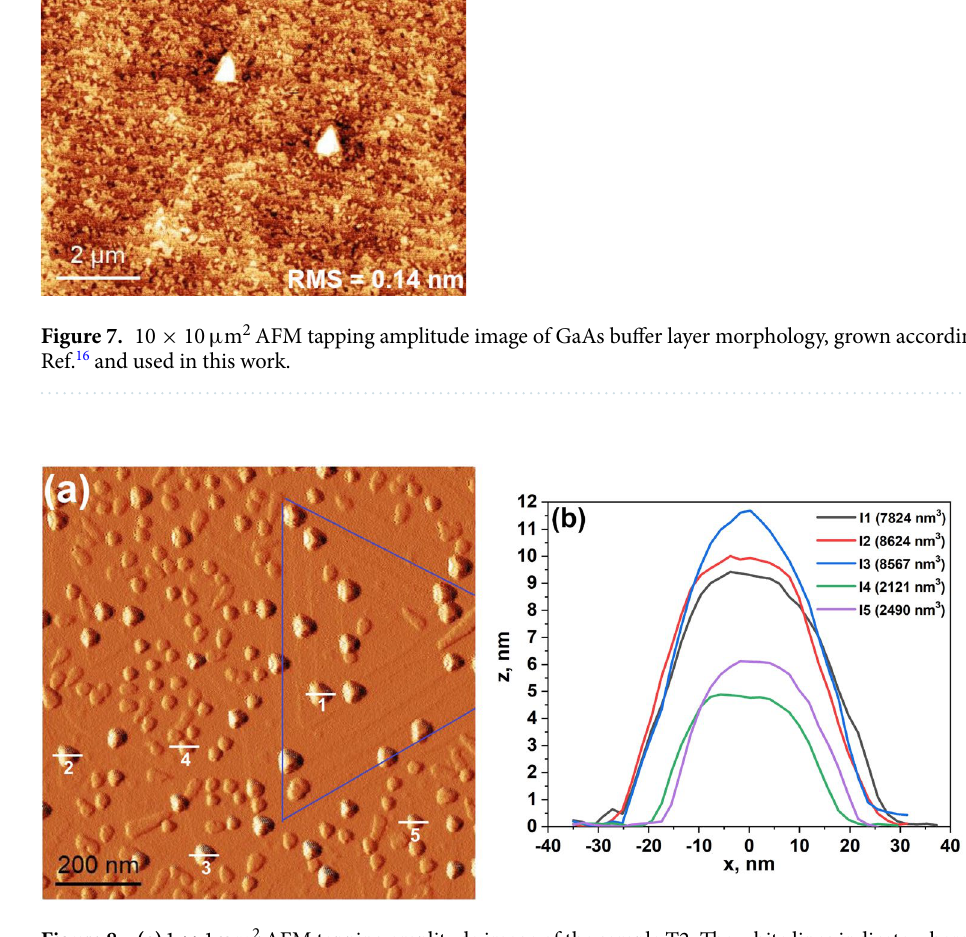
Figure 8. (a) 1 × 1 µ m 2 AFM tapping amplitude image of the sample T2. The white lines indicate where the height profiles of islands were measured. The blue lines indicate the area of the stepped hillock. (b) The height profiles of 5 islands of the sample taken from (a)